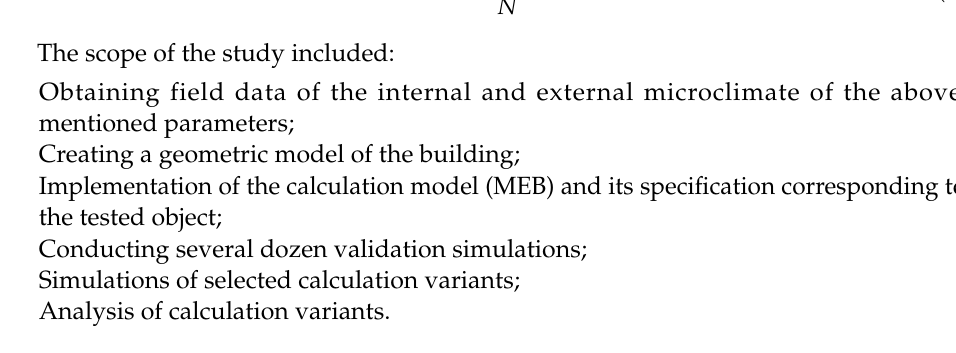
Table 1. Physical parameters of materials implemented in the computational model.